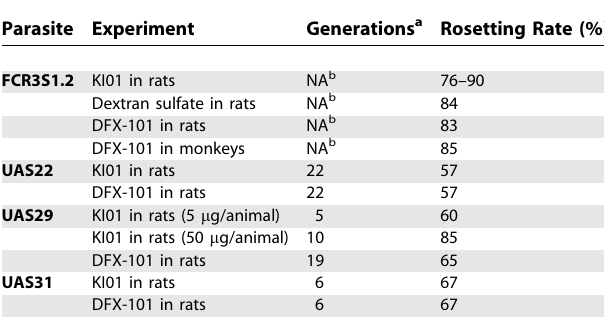
Table 2. Rosetting Rates and Number of Generation of In Vitro Growth of Parasites Used in the Animal Experiments Parasite Experiment